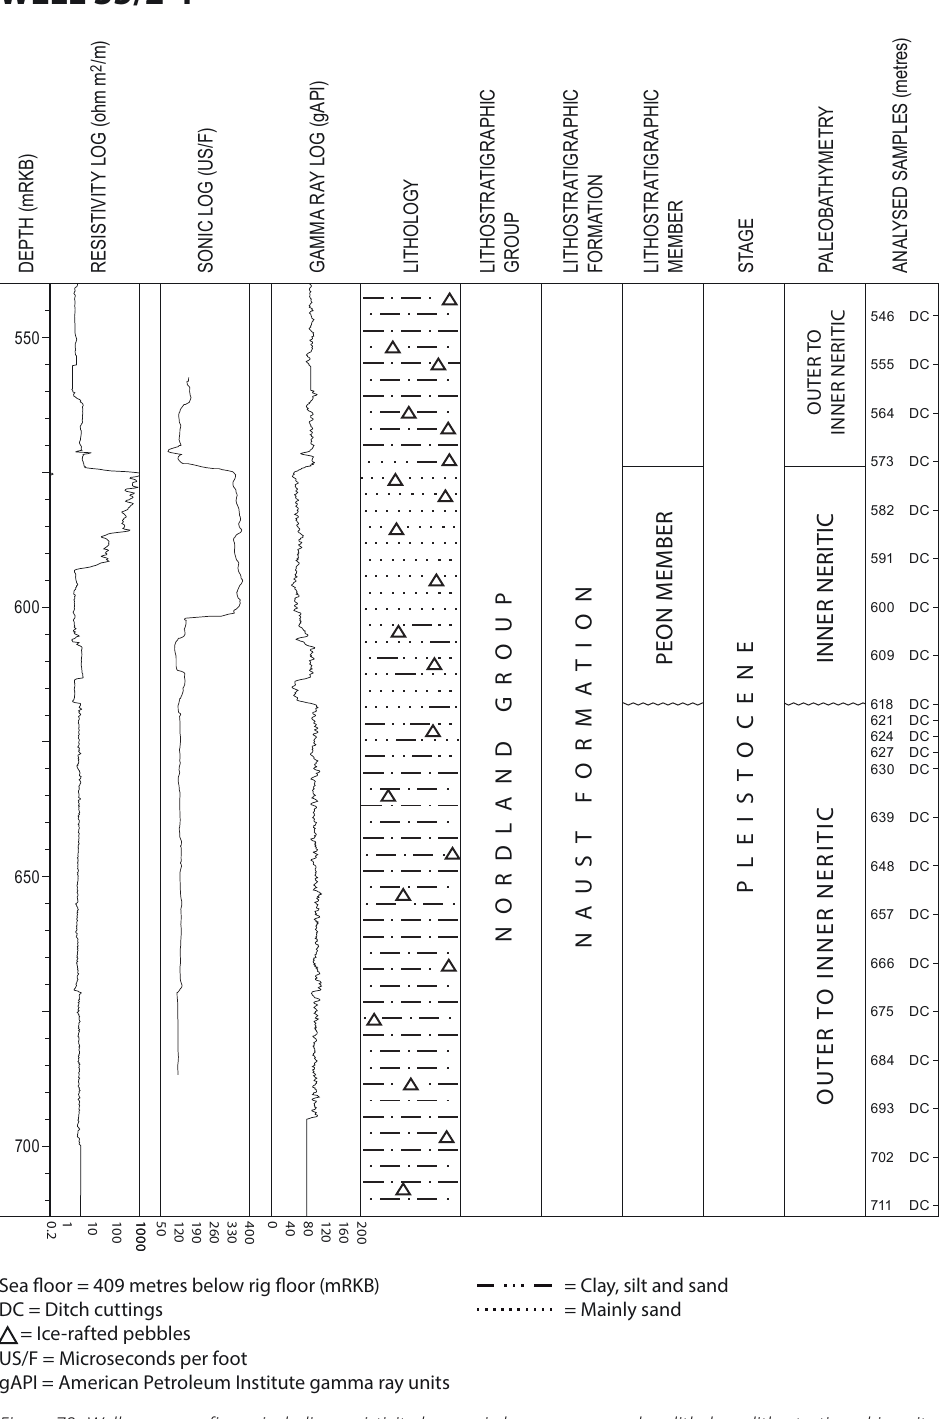
Figure 70. Well summary figure including resistivity log, sonic log, gamma-ray log, lithology, lithostratigraphic units, stage, paleobathymetry and analysed samples for the investigated sequence in well 35/2–1 (Pleistocene) including the type well section for the Peon Member (modified after Eidvin,